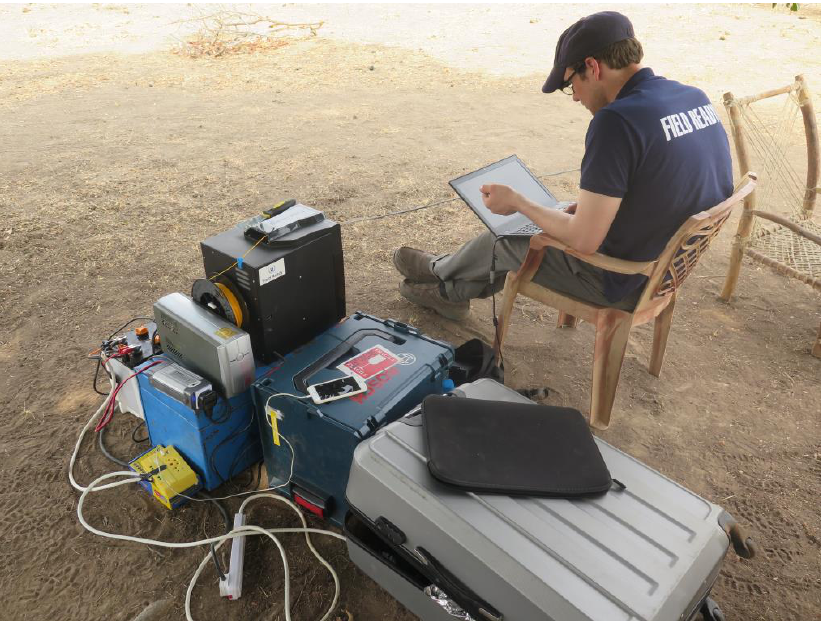
Figure 1. Field Ready 3-D Printer being supported with a variety of supplementary technologies in South Sudan (Photo Credit: Andrew Lamb, Field Ready).